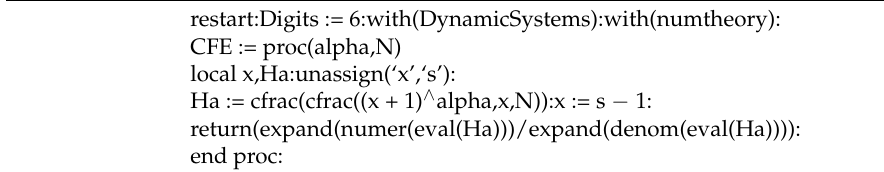
Table 12. Code in Maple 18 environment of